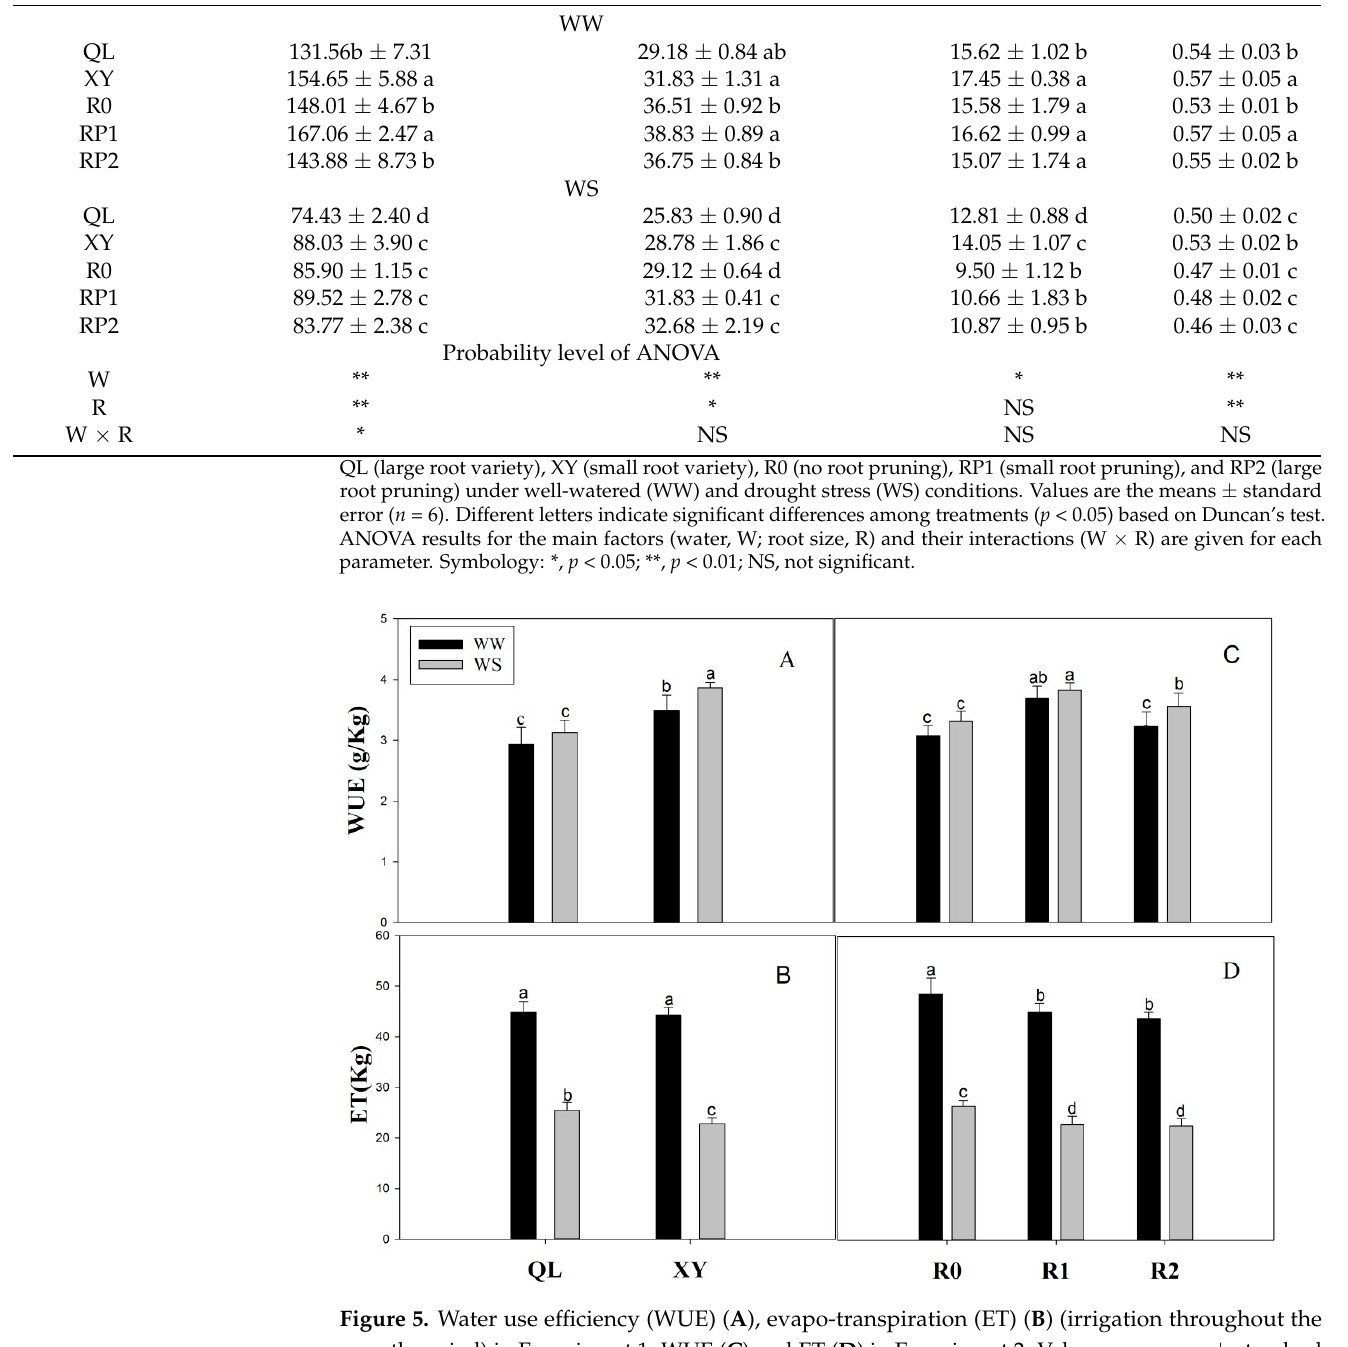
Table 2. Yield and yield-related components under well-watered (WW) and drought stress (WS) conditions. Treatment Grain Yield (g/pot)